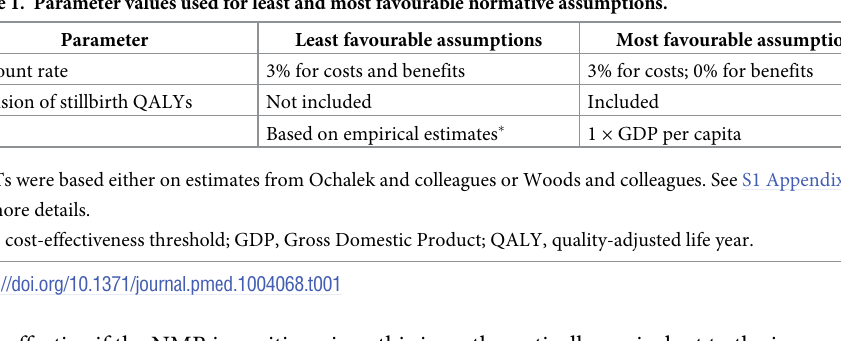
Table 1. Parameter values used for least and most favourable normative assumptions. Parameter